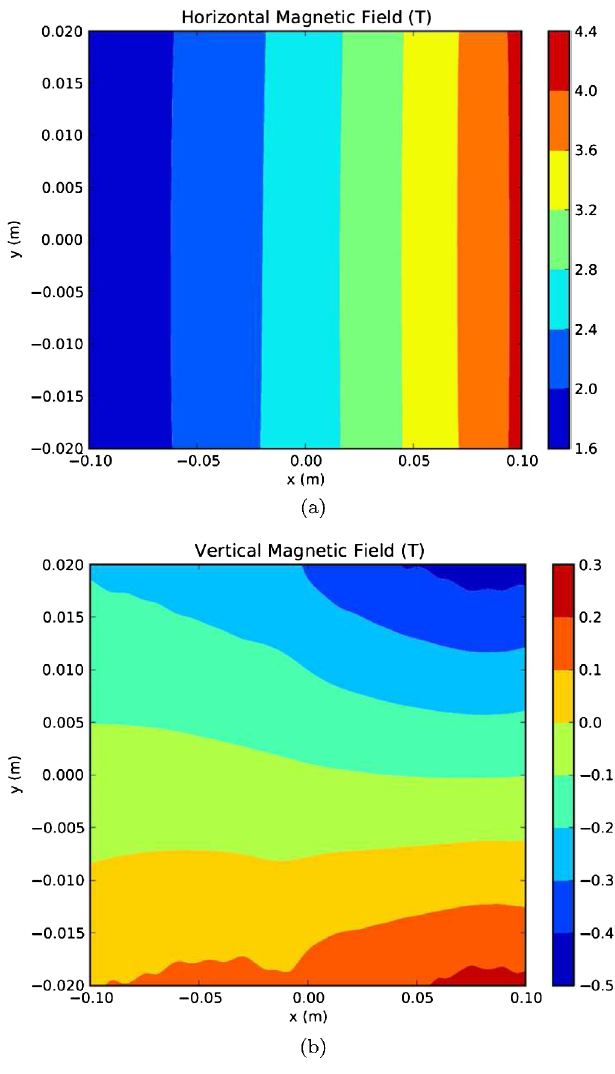
FIG. 45. Integrated horizontal (a) and vertical (b) magnetic field in the septum bore as a function of the position.